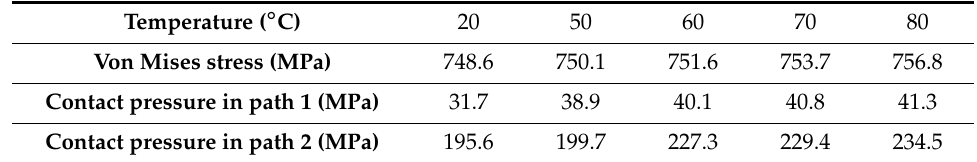
Table 2. Results of the FE model at di ff erent